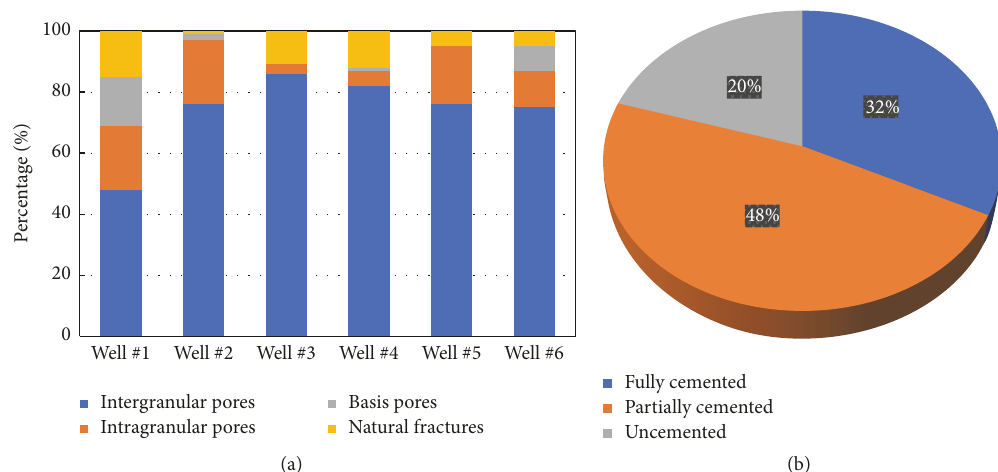
Figure 2: Percentages of different types of pores (a) and cementation of natural fractures (b) in the reservoir rock.